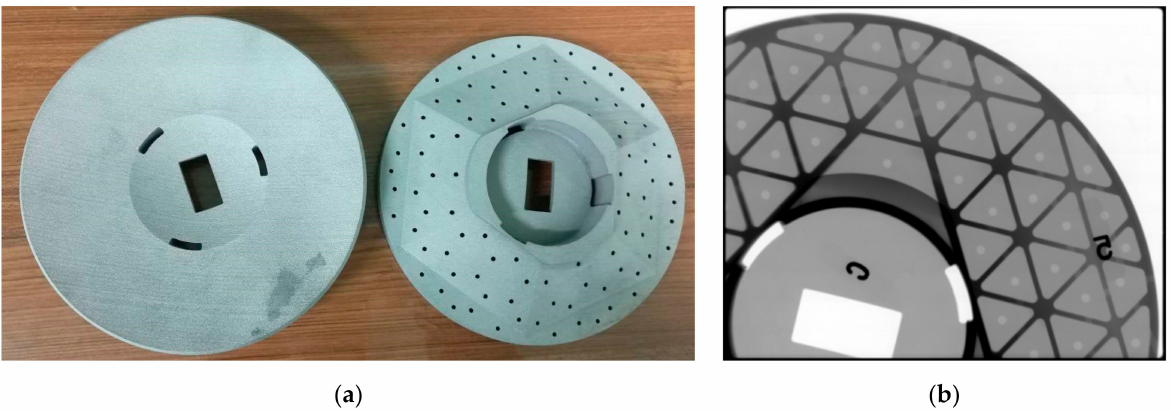
Figure 9. ( a ) AM mirror blanks after cleaning; ( b ) X-ray inspection image for the AM mirror blank (the letter and number are locating